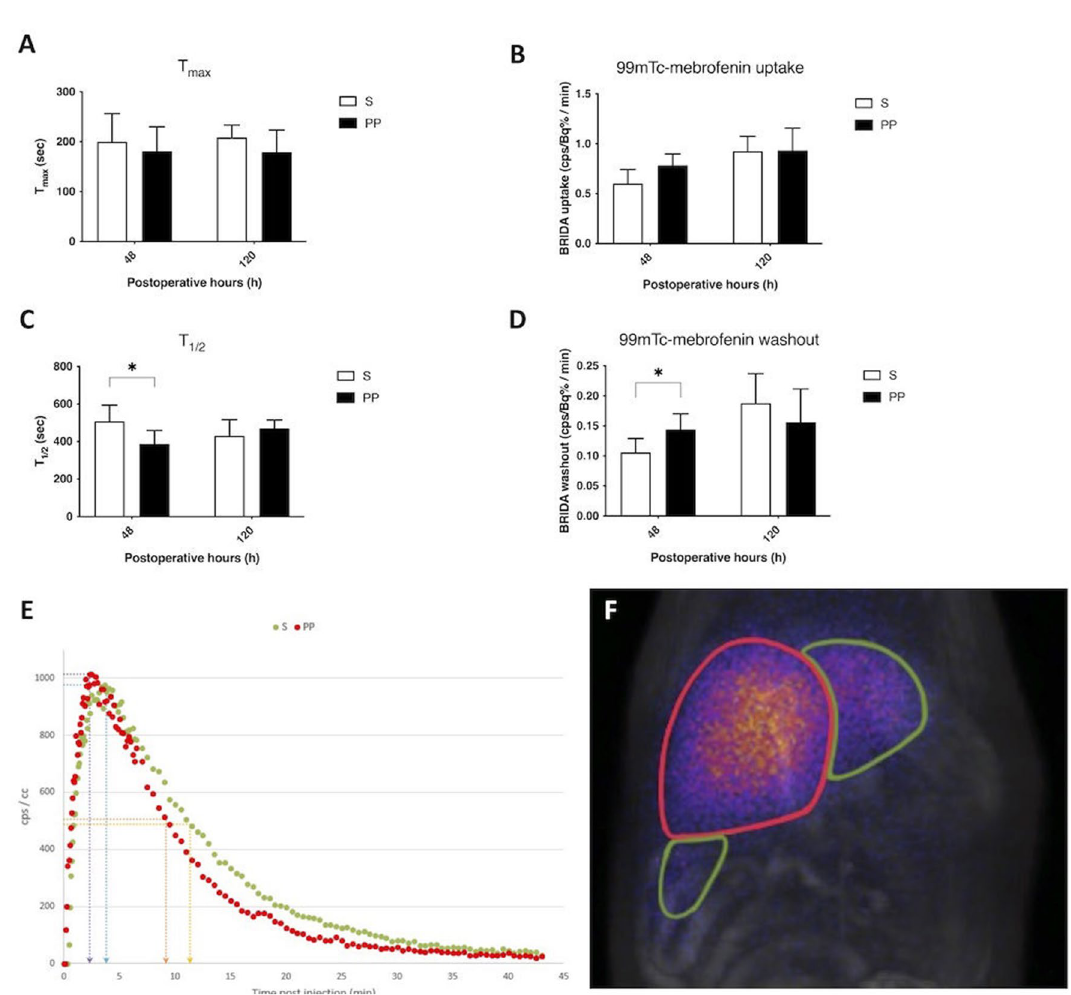
Figure 3. Changes in liver function measured by 99mTc-mebrofenin hepatobiliary scintigraphy (HBS). Time of maximum (T 1/2 ) 99mTc-mebrofenin concentration and total 99mTc-mebrofenin washout ( D ) preoperatively (preop., 0 h), and at 24 h, 48 h, 72 h, and 168 h after associating liver partition and portal vein ligation for staged hepatectomy (ALPPS) (N = 6 per time point per group). Representative curve of 99mTc-mebrofenin concentration in the change of time ( E ) with T max of the PP group (purple arrow), T max of the S group (blue arrow), T 1/2 of the PP group (orange arrow) and T 1/2 of the S group (yellow arrow). Representative figure of 99mTc-mebrofenin HBS 48 h after ALPPS in the PP group ( F ) showing a notable difference of 99mTc-mebrofenin uptake between the functional liver remnant (FLR) and the ligated lobes . * p < 0.050, ** p < 0.0010 physical prehabilitation (PP) versus sedentary